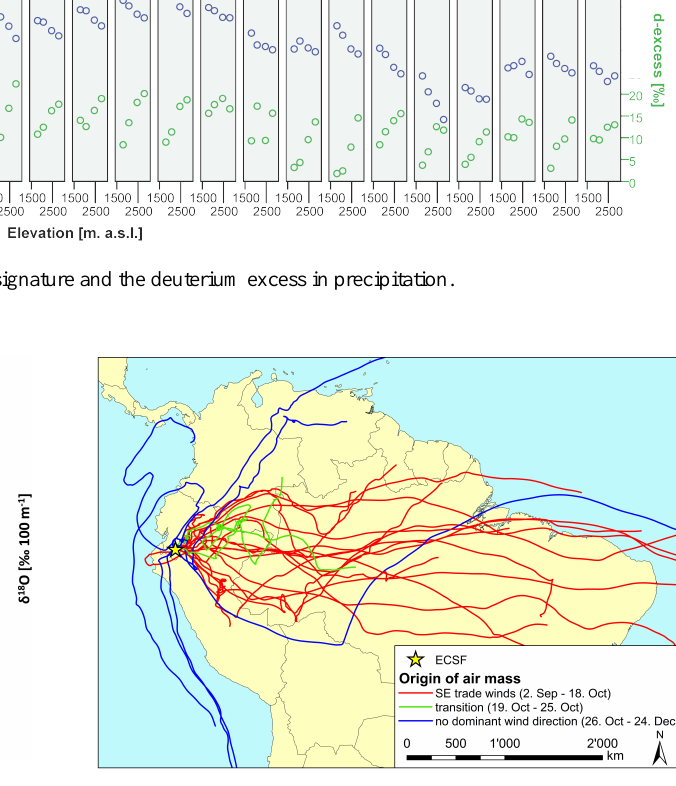
Fig. 4. Event-based altitude effect of δ 18 O and δ 2 H isotope signa- tures in precipitation. The majority of the events show a depletion of heavy isotopes with altitude (i.e. a negative lapse rate). Only dur- ing 3 events for 2 H and 2 events for 18 O out of 26 events was an enrichment of heavy isotopes with altitude recorded.